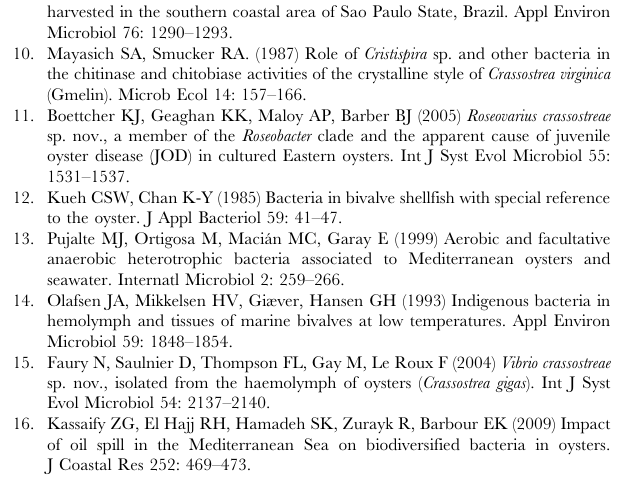
Figure S1 Principal components analysis of percent composition of each of the replicate Hackberry Bay (HB) and Lake Caillou (LC) stomach (S) and gut microbiomes (G) for sequences derived from the CloVR pipeline; percentages were analyzed using an arcsin transform. Table S1 Composition of trimmed data sets for three sequence processing pipelines using trim variable values as defined in the text. The percentages of cyanobacterial and eukaryotic sequences reflect removal of singletons and